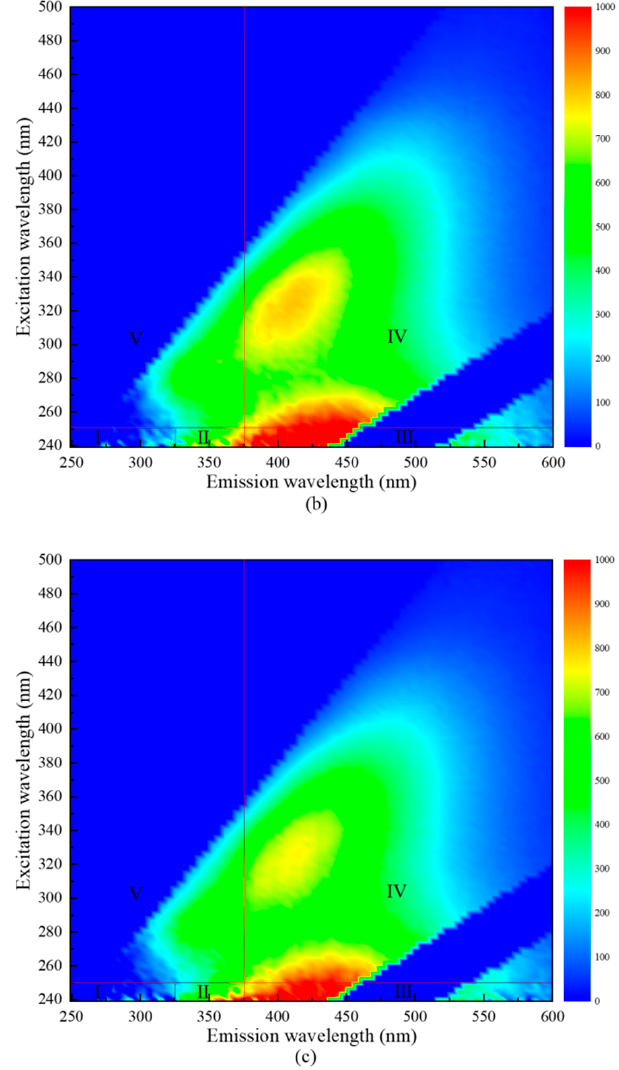
Figure 5. Three-dimensional fluorescence analysis of organic matter after combined disinfection treatment. ( a ) Raw water; ( b ) “Method A”; ( c ) “Method B”.